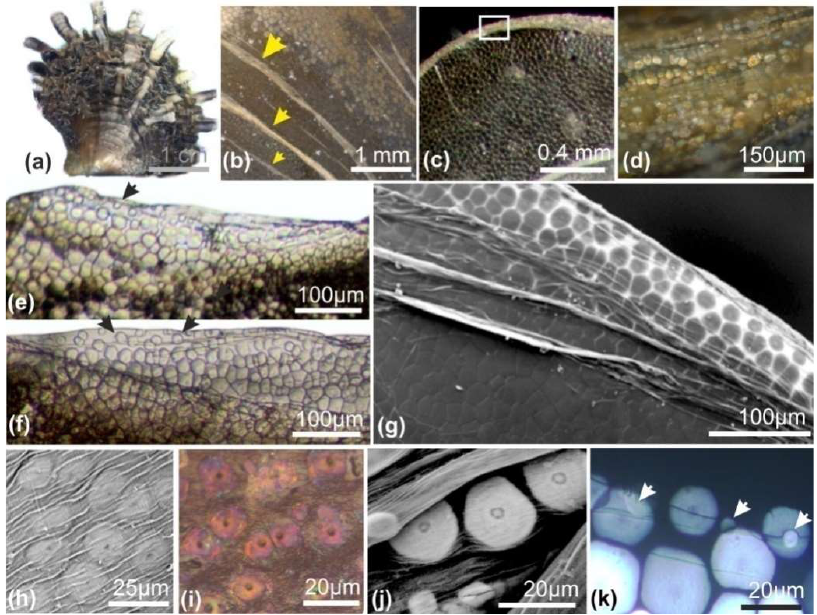
Figure 2. Pinctada margaritifera: discoid mineralized structures on the internal side of the periostracum. ( a ) Scaly aspect of the shell due to the series of back-and-forth movements of the mantle. ( b , c ) Remains of the periostracum on the outer surface of the shell. ( d ) Enlarged view of a periostracal remain: note the presence of the polarizing disks in the enrolled membrane. ( e , f ) Flat growing edge of the shell showing the round shaped disks at the forefront. ( g ) SEM view of an equivalent area. ( h – k ) Different equivalent views of the periostracal disks at the growing edge of the shell growth lamella. ( h ) Disks and central nodule viewed by SEM outer surface of the periostracum. ( i ) Optical microscopy (polarized episcopy). ( j ) SEM view of the folded periostracum showing the different growth statuses of the disks. ( k ) Equivalent area in transmitted polarized light. Note that the young disks (arrows) are apparently superposed to the older ones, due to periostracum folding. Credit pictures: (g,j) [25].